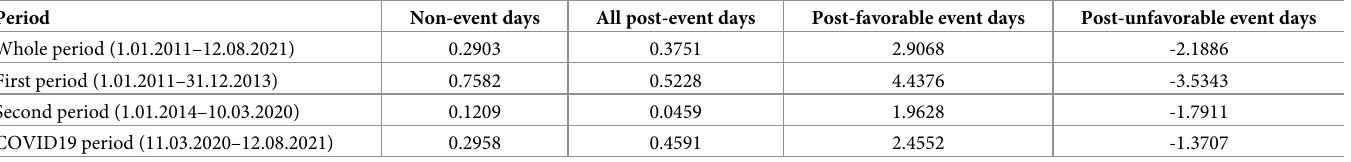
Table 2. Mean Bitcoin daily returns for non-event and post-event days.